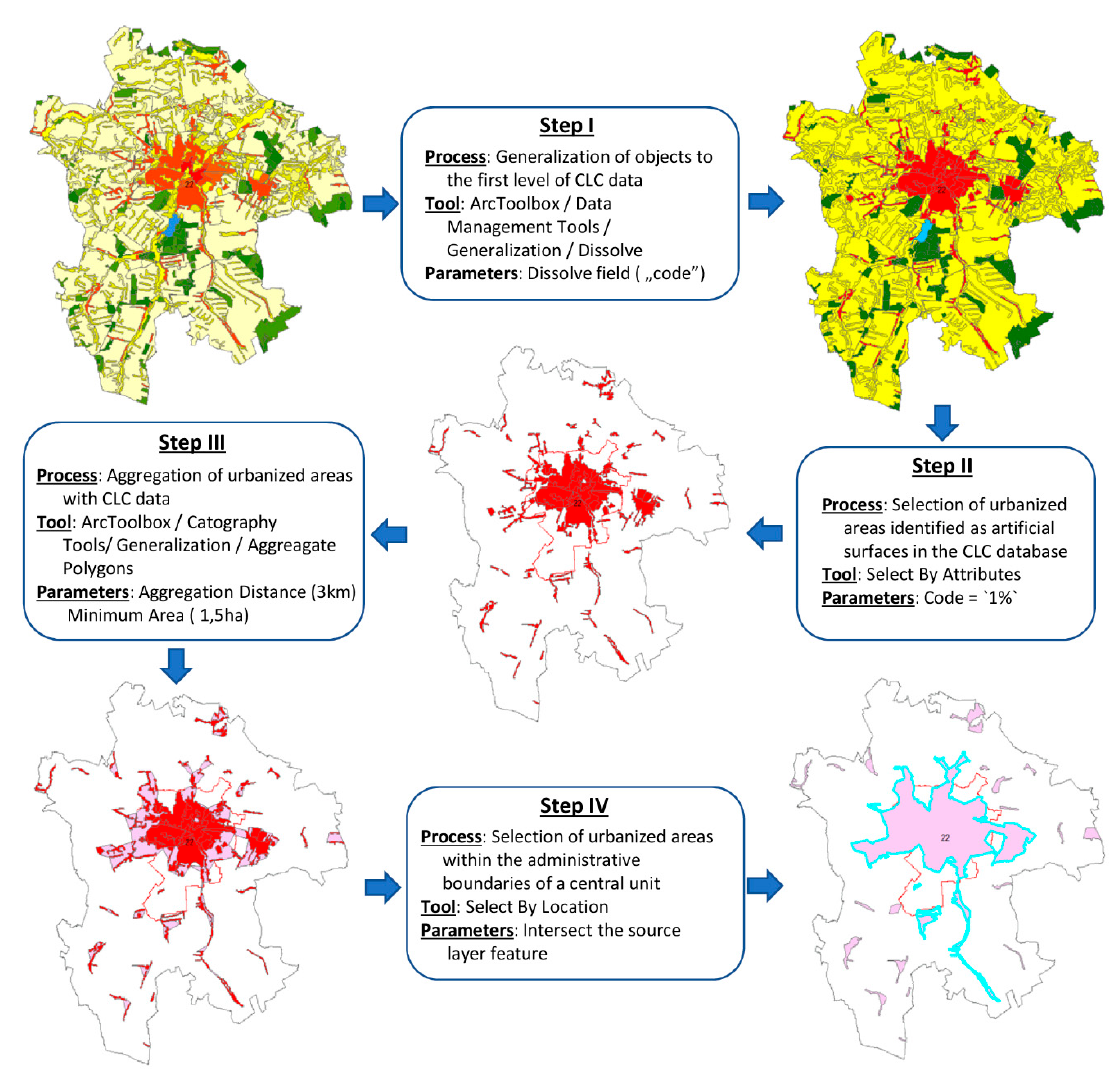
Figure 3. The application of Geographic Information System (GIS) tools for spatial analysis.